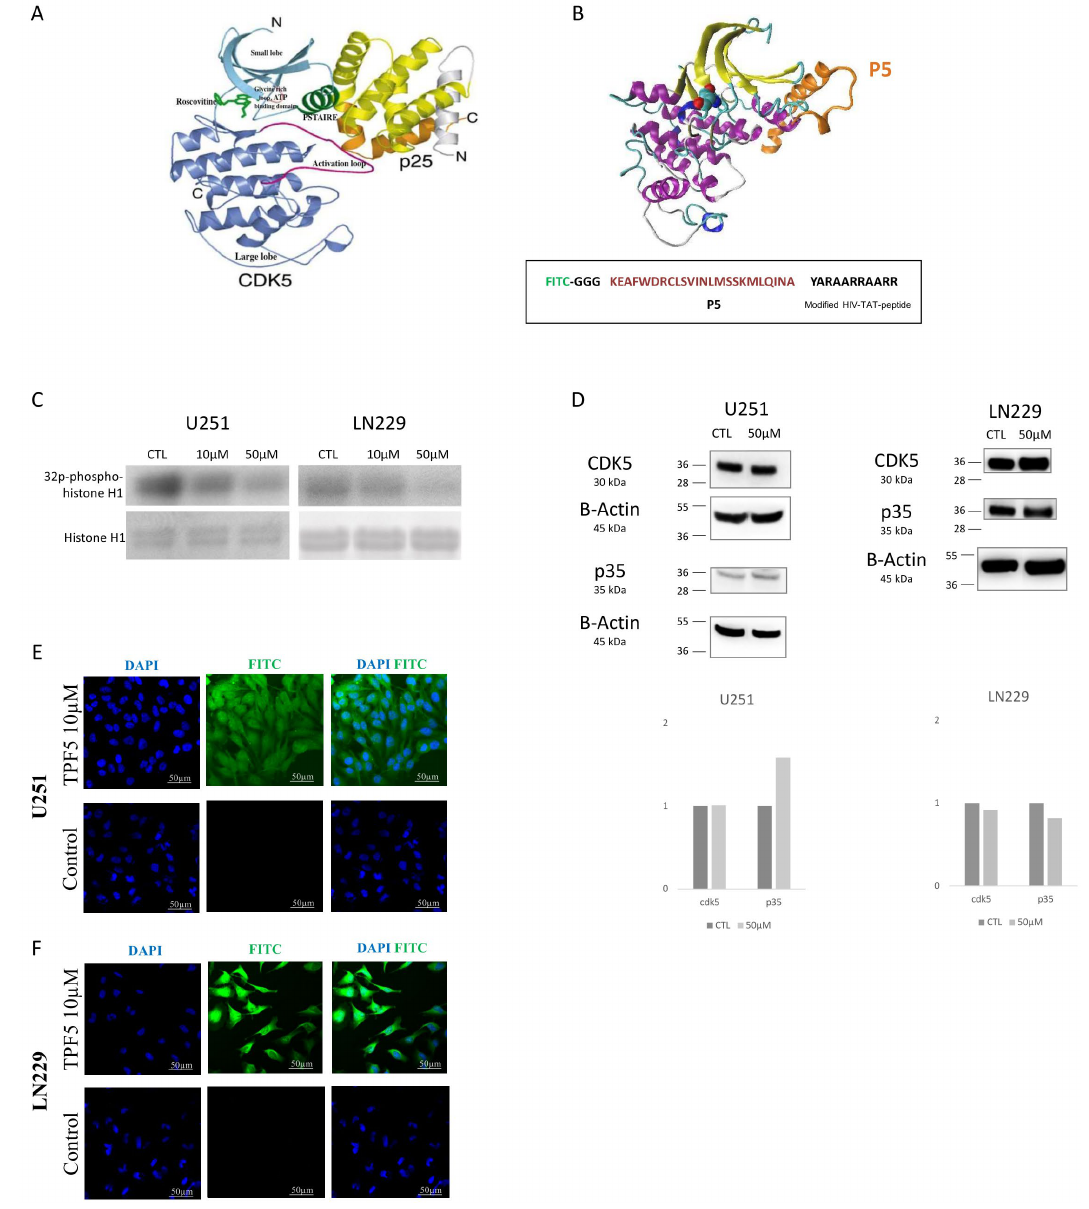
Figure 1. TPF5 structure and activity. ( A ) Crystal structure of the pathologic CDK5/P25 complex.